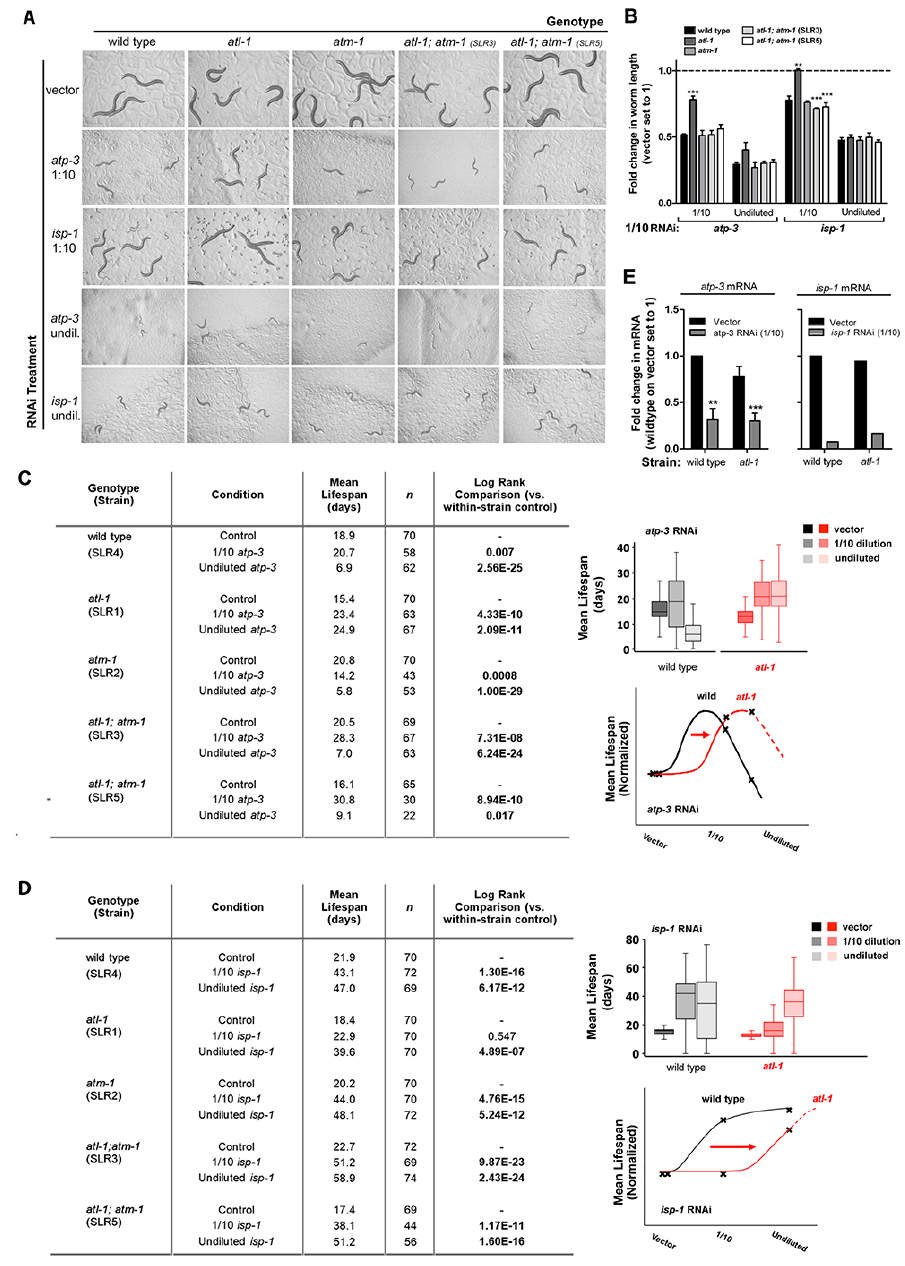
Figure 1. Loss of ATL-1 desensitizes worms to mitochondrial respiratory chain stress. ( A , B ) atl- 1(tm853) knockout mutants are resistant to size reduction induced by atp-3 or isp-1 bacterial feeding RNAi ( panel A ). Tested worms include wild type, atm-1(gk186) and atl-1(tm853) single mutants, as well as two independent atl-1(tm853) ; atm-1(gk186) lines. Worm length is quantified in panel B . All worms were seeded at the same time. Each row was photographed at a common time interval after seeding. This interval increased with increasing RNAi potency, since worms matured more slowly. Evident across rows are differences in growth rates when strains are cultured on the same RNAi treatment. In ( B ), error bars refer to SEM. Asterisks refer to significant difference relative to respec- tive wild type sample (Students’ t -test): ** p < 0.01, *** p < 0.001. ( C , D ) Charts on left : Adult lifespan of worm strains tested in ( A ). Shown is a representative study. Samples listed in each table were tested in parallel. For each strain, a synchronous population of 8000 eggs was distributed over the three relevant test conditions. After hatching, unbalanced worms were retrieved (~1/16th). Replicate data for atp-3 are presented in Figure 2. Right panels : ( Top ) Box plots showing lifespan distribution of selected worm populations from chart on left. Box shows mean +/ − 25%. Bars: 5–95%. ( Bottom )